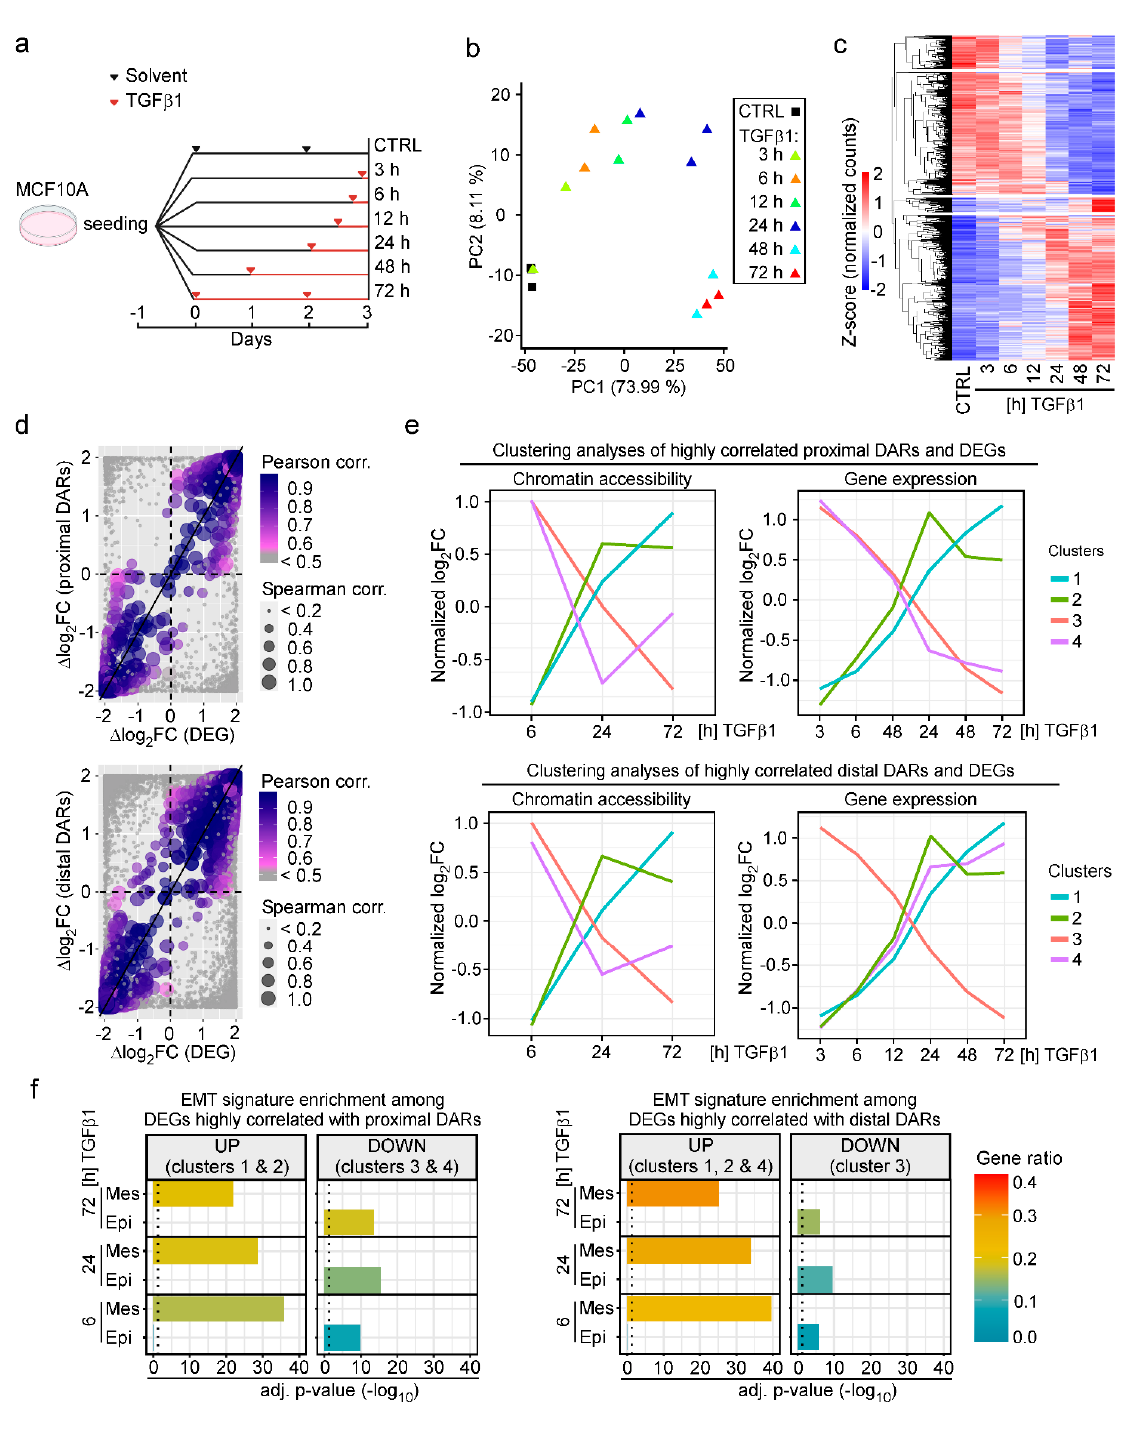
Figure 2. TGF β 1-induced changes in chromatin accessibility and gene expression changes are highly correlated and indicate acquisition of an EMT phenotype. ( a ) Experimental setup of the RNA-seq experiment. MCF10A cells were seeded in seven cell culture dishes and treated with 5 ng/mL TGF β